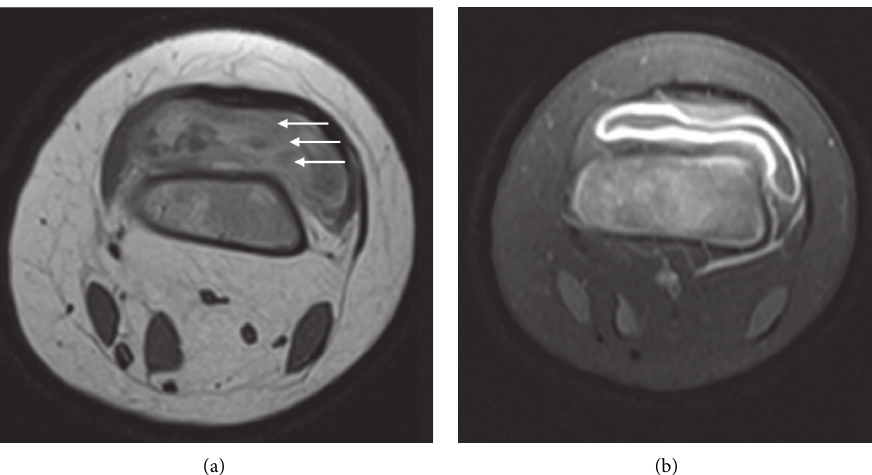
Figure 6: Axial T2 (a) and T1FS postcontrast (b) MRI of the knee in a 6-year-old boy. Lamellated synovial thickening (a) is specific for septic arthritis.